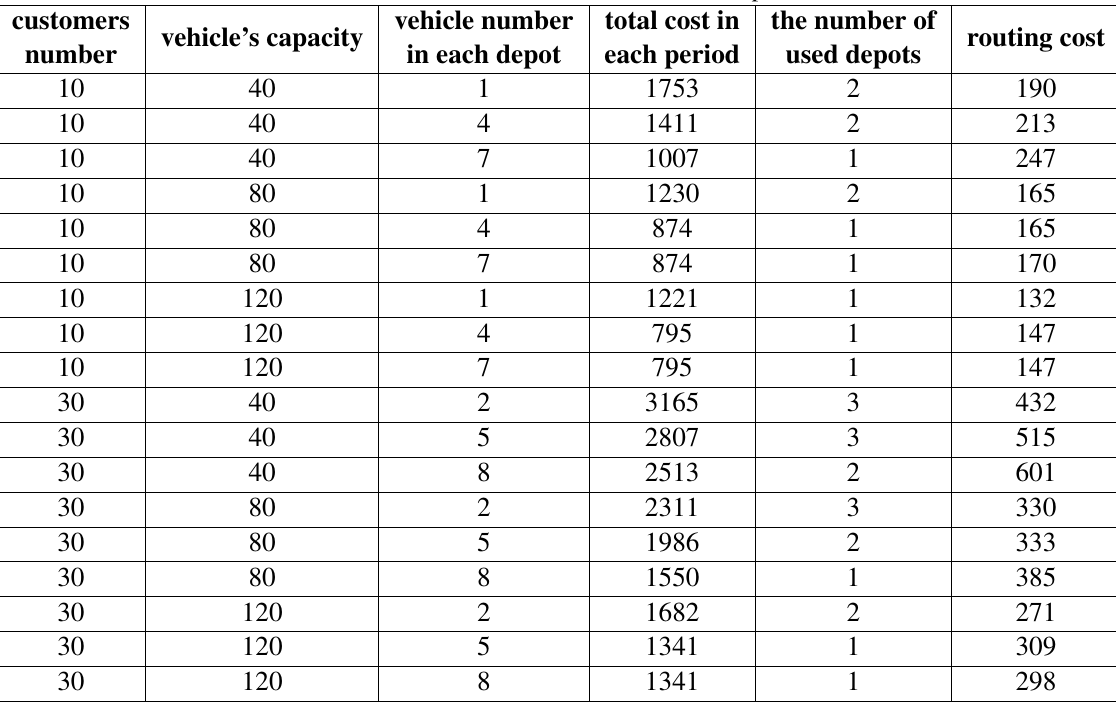
Table 2 Calculation results of the numerical